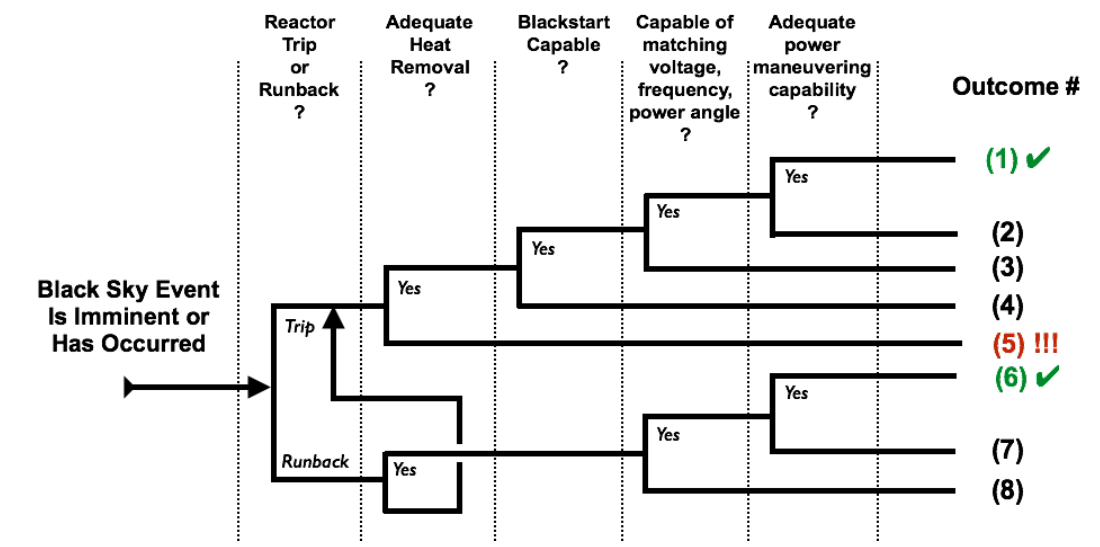
Figure 7. NPP Black Sky Evaluation Framework (Source: S. R. Greene, Advanced Technology Insights,